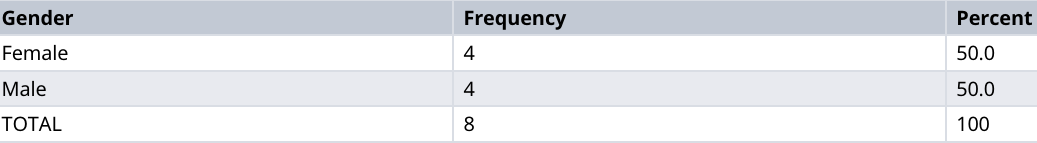
Table 1. Total number of